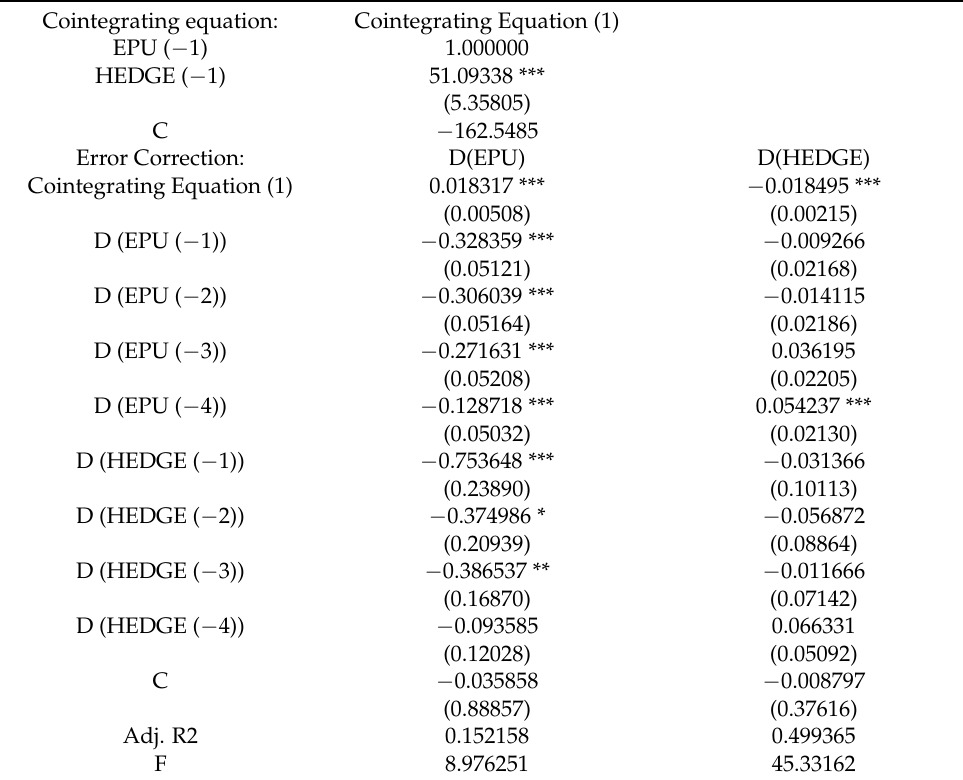
Table 11. Vector error correction